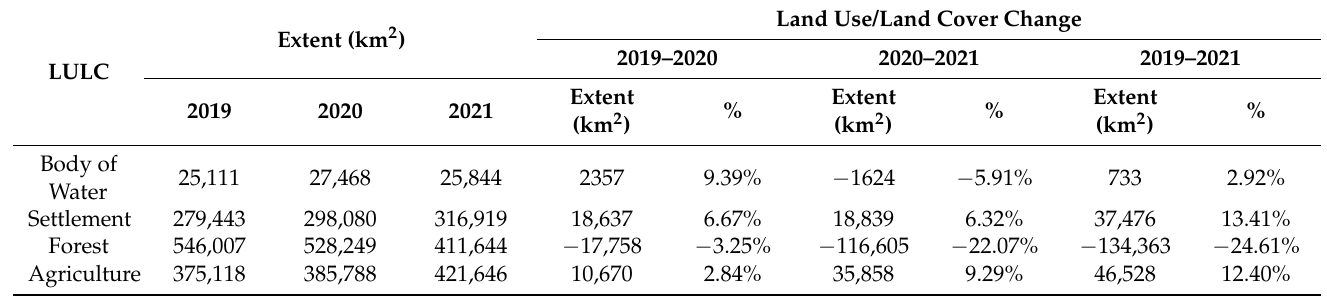
Table 3. Land use/land cover change between 2019 and